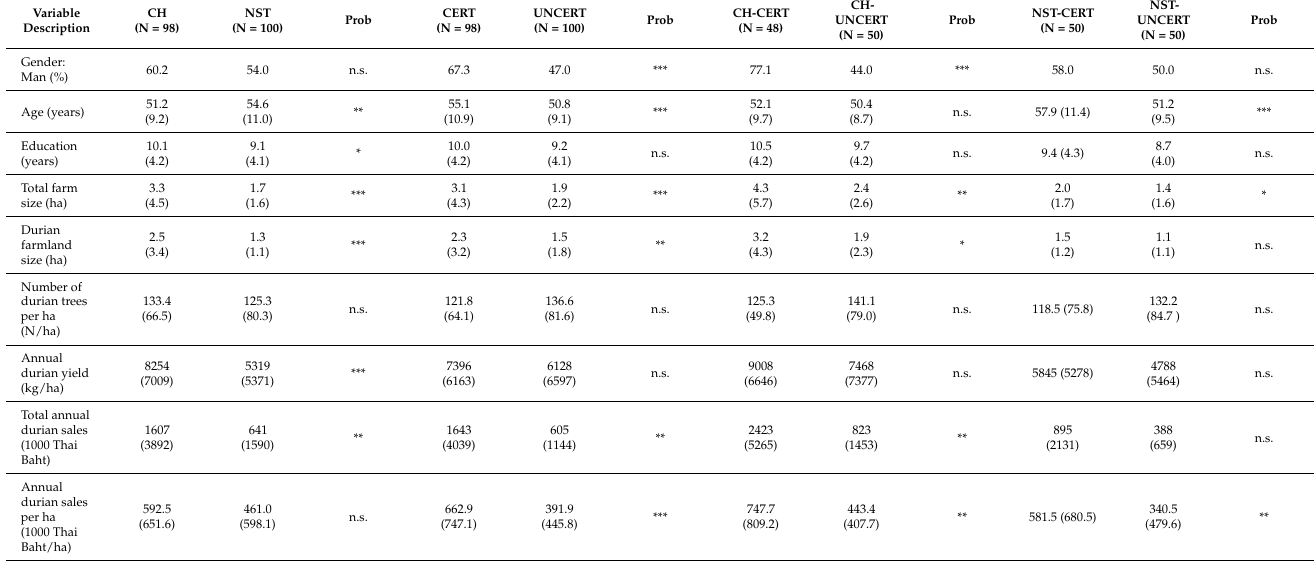
Table 1. Socioeconomic profile of the respondent farmers with respect to the two provinces (CH vs. NST) and the two farm types (certified vs. uncertified) according to the results of a two-way ANOVA.